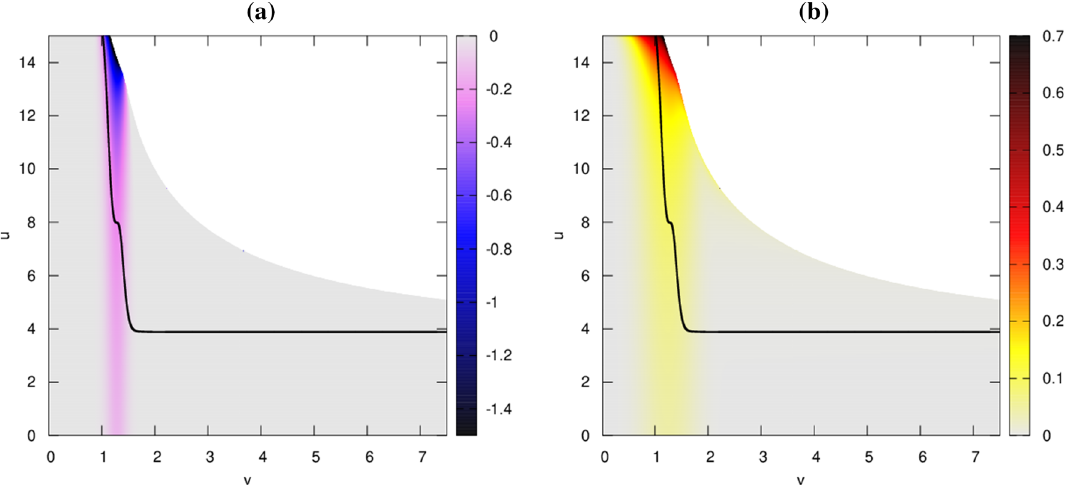
Fig. 10 The (v u ) -distribution of a the neutral scalar field, h , and b the moduli of the complex scalar field, | s | , for the same parameters and field amplitudes as in Fig.